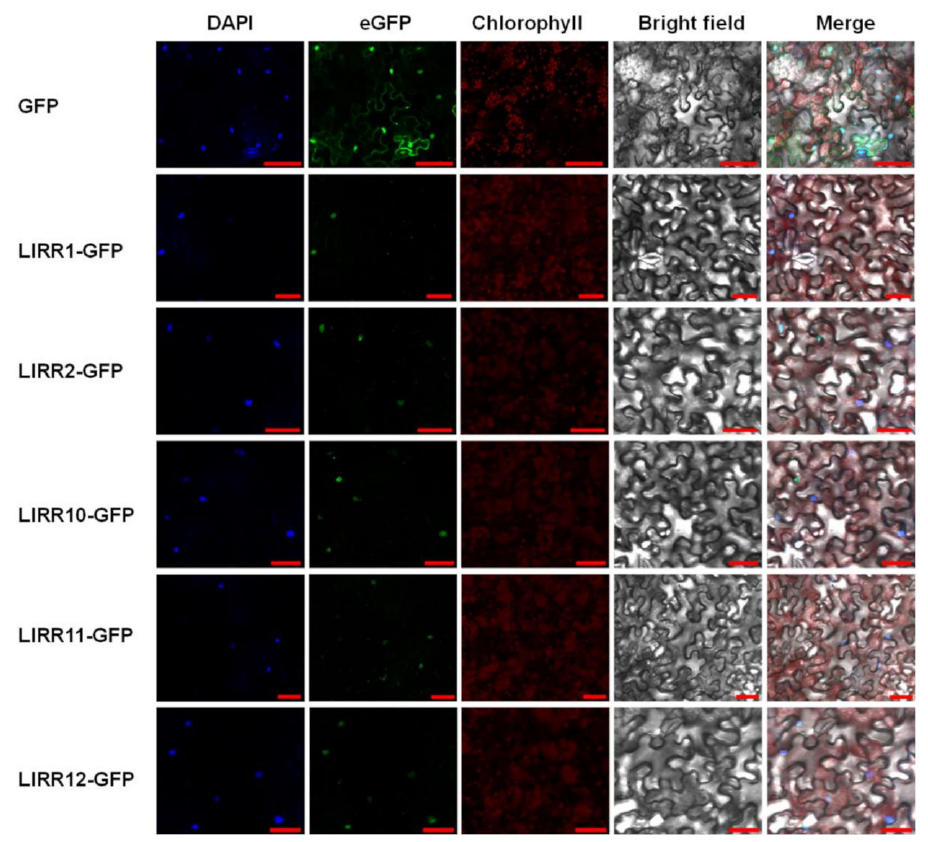
Figure 3. Localization of five type-B LlRR–GFP proteins in Nicotiana benthamiana leaf epidermal cells. The localization of the nuclei was detected by 4 (cid:48) ,6-diamidino-2-phenylindole (DAPI) staining. DAPI: blue fluorescence signal. Blue fluorescence indicates the location of the nucleus stained by DAPI; GFP: GFP fluorescence signal. Green fluorescence indicates the location of GFP in the N. benthamiana leaf epidermal cells; Chlorophyll: chlorophyll autofluorescence signal. Red fluorescent signal indicates the location of chloroplasts in leaf epidermal cells. Scale bar, 50 µ m.